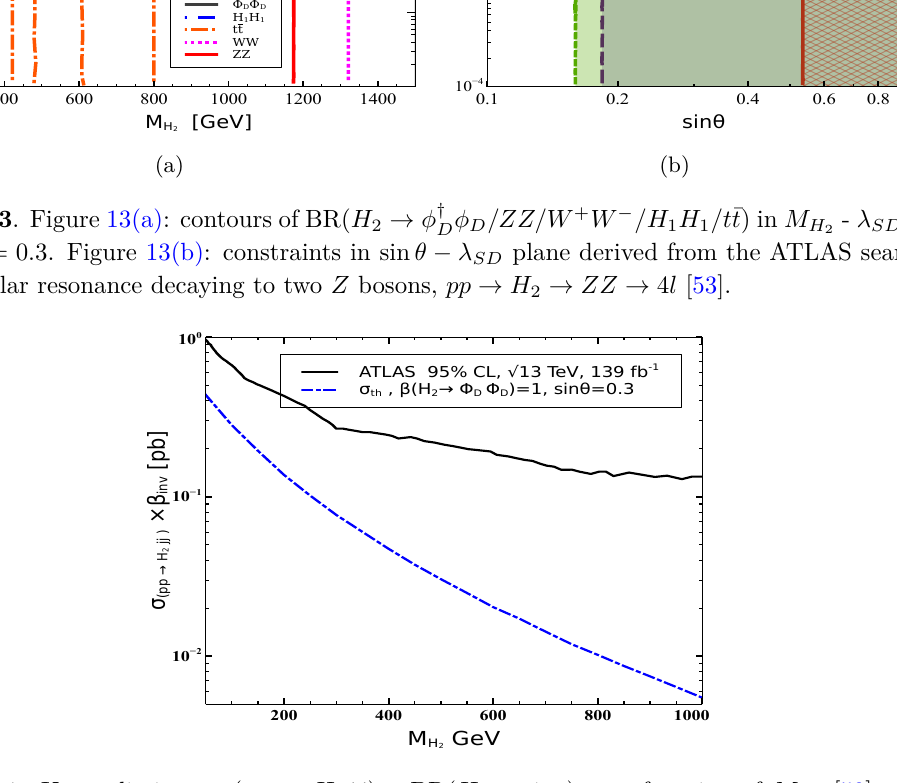
Figure 14 . Upper limit on σ ( pp → H 2 jj ) × BR ( H 2 → inv ) as a function of M H comparision with the theory